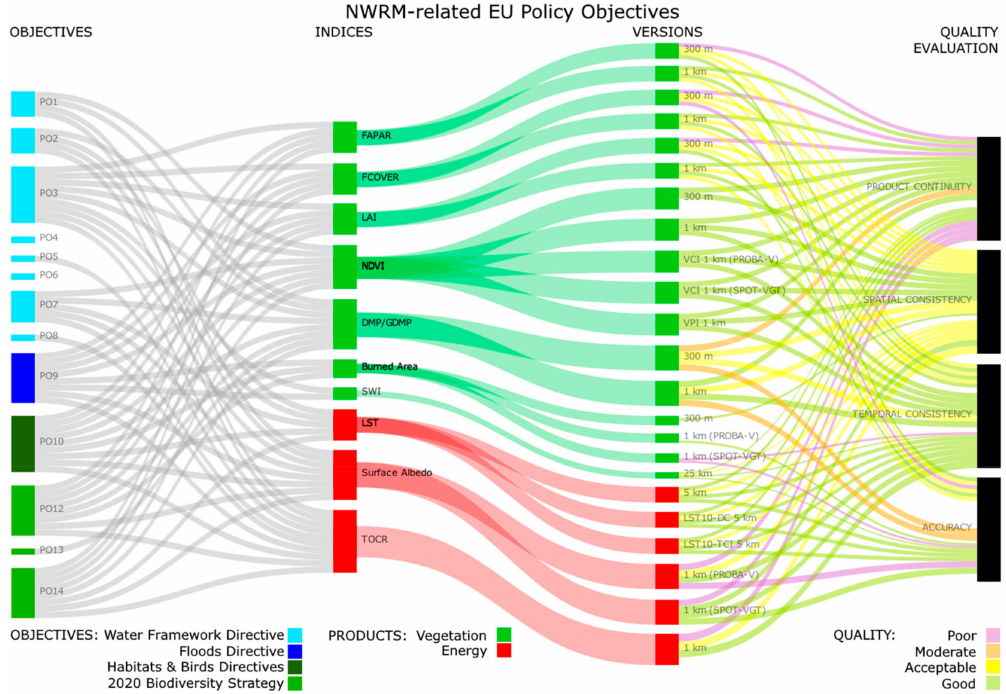
Figure A6. Sankey diagram linking the vegetation and energy indices that according to previous experiences are suitable for monitoring the achievement of policy objectives (PO) through the application of natural water retention measures